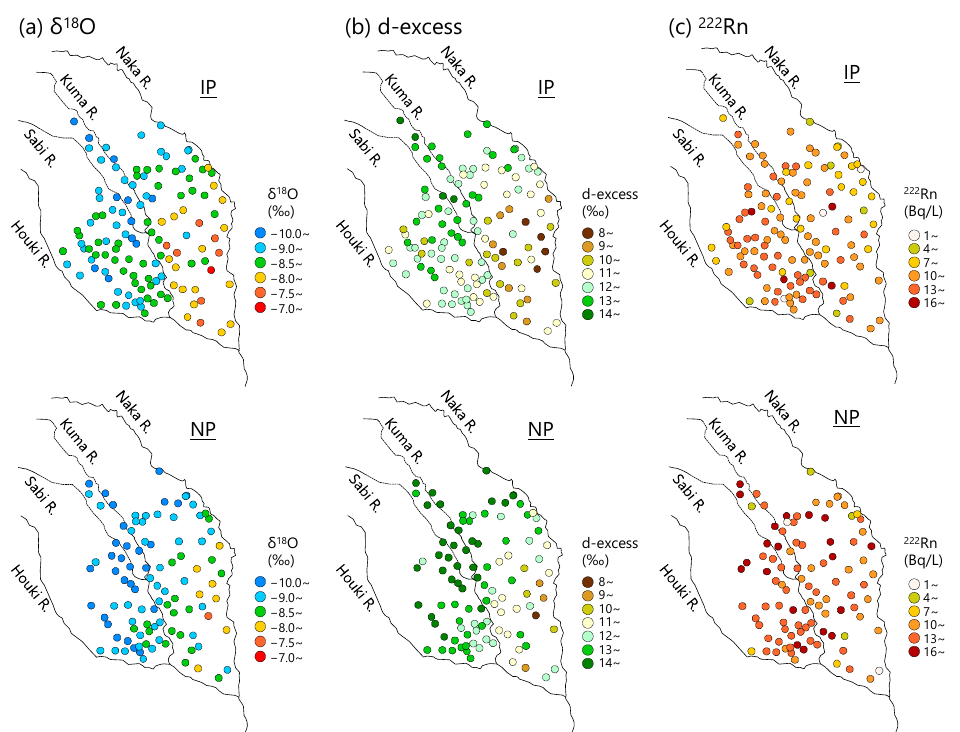
Figure 9. Distributions of ( a ) δ 18 O, ( b ) d-excess, and ( c ) the 222 Rn concentration in groundwater in the IP (upper maps) and NP (lower maps).